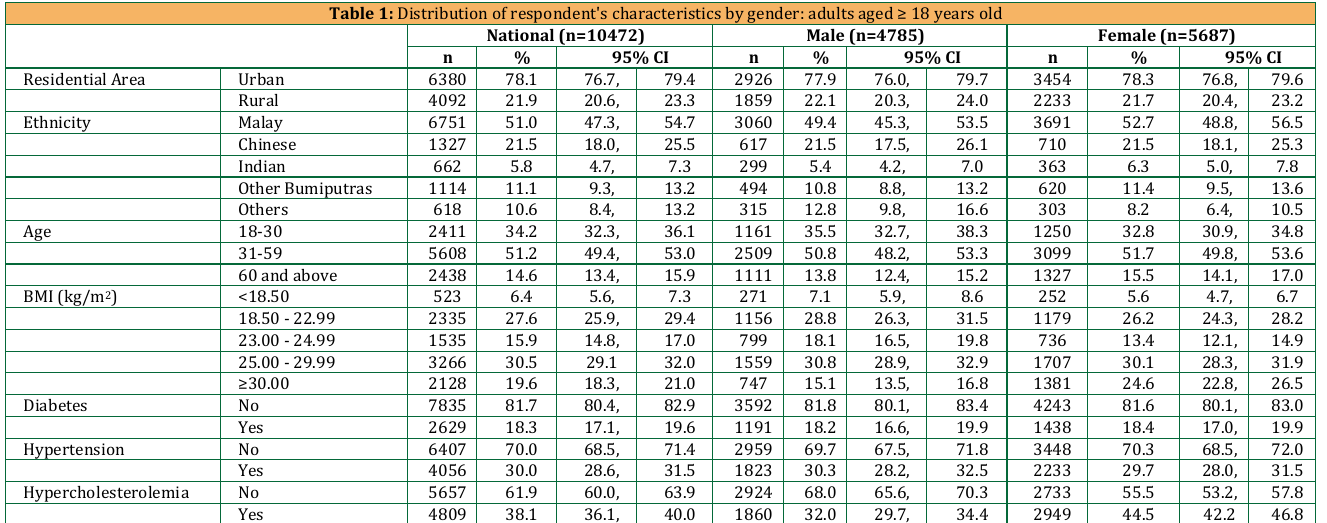
Table 1: Distribution of respondent's characteristics by gender: adults aged ≥ 18 years old National